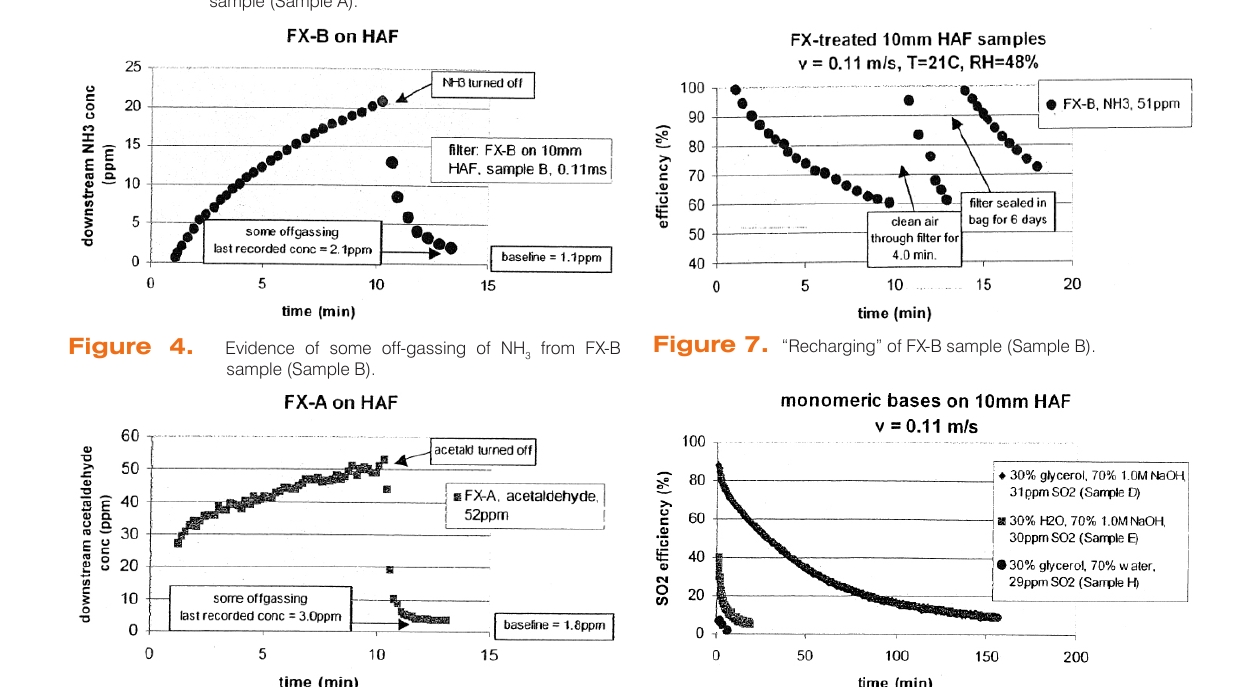
Figure 5. Evidence of some off-gassing of acetaldehyde from FX-A sample (Sample C).